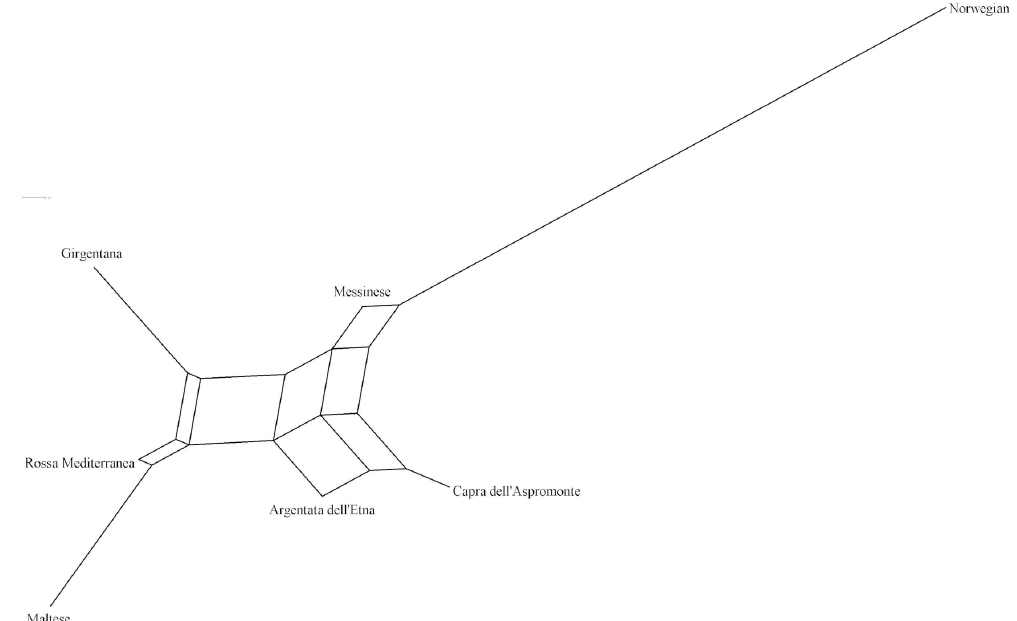
Figure 1. Neighbour-Net obtained from D s distance among the seven goat breeds.